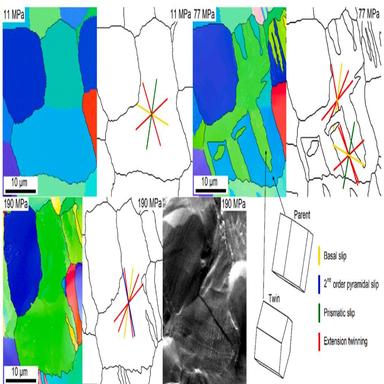
A slip trace analysis-based illustration of the extension twinning followed by the activation of basal slip in the RD sample.